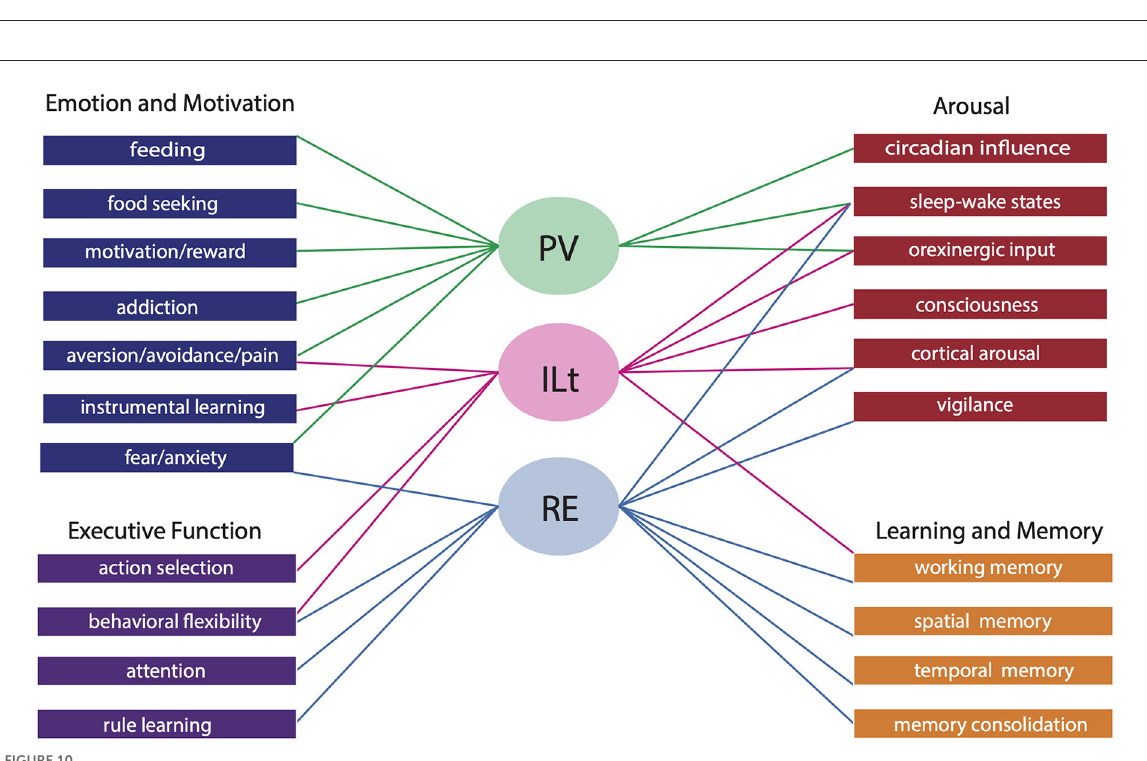
FIGURE10 Schematic diagram illustrating the shared and unique functional contributions of the paraventricular nucleus (PV) of the dorsal midline thalamus, the nucleus reuniens (RE) of the ventral midline thalamus and the central medial, central lateral and paracentral nuclei of the rostral intralaminar thalamus (ILt). Both the midline and intralaminar nuclei participate in distinct roles in arousal, emotion, motivation and cognition. For instance, both PV and ILt have been linked to motivated behaviors, however PV plays a key role in feeding, appetitive and aversive conditioning and addiction while the ILt participates in instrumental conditioning and pain perception. By comparison, RE is involved in circuitry influencing innate and learned fear/anxiety. Similarly, the midline and intralaminar thalamus collectively drives arousal, however the ILt maintains consciousness while the midline nuclei receive hypothalamic and brainstem input which modulate states of arousal for effective responding—PV for circadian linked behaviors including feeding and RE for attentional/vigilant responding. Lastly, RE and the ILt contribute largely to cognition and both share a role in flexible goal directed behavior and working memory (WM), but each group inimitably subserve dissociable processes. RE is linked to attention in addition to the spatial and temporal components of WM/long-term memory while the ILt facilitates the sensorimotor components of